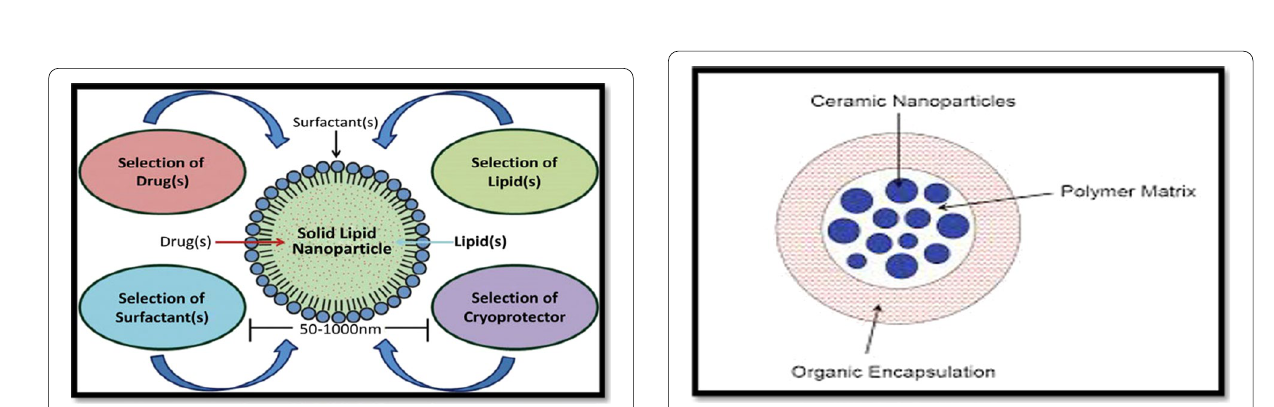
Fig. 3 Schematic representation of solid lipid nanoparticle [12, 13]